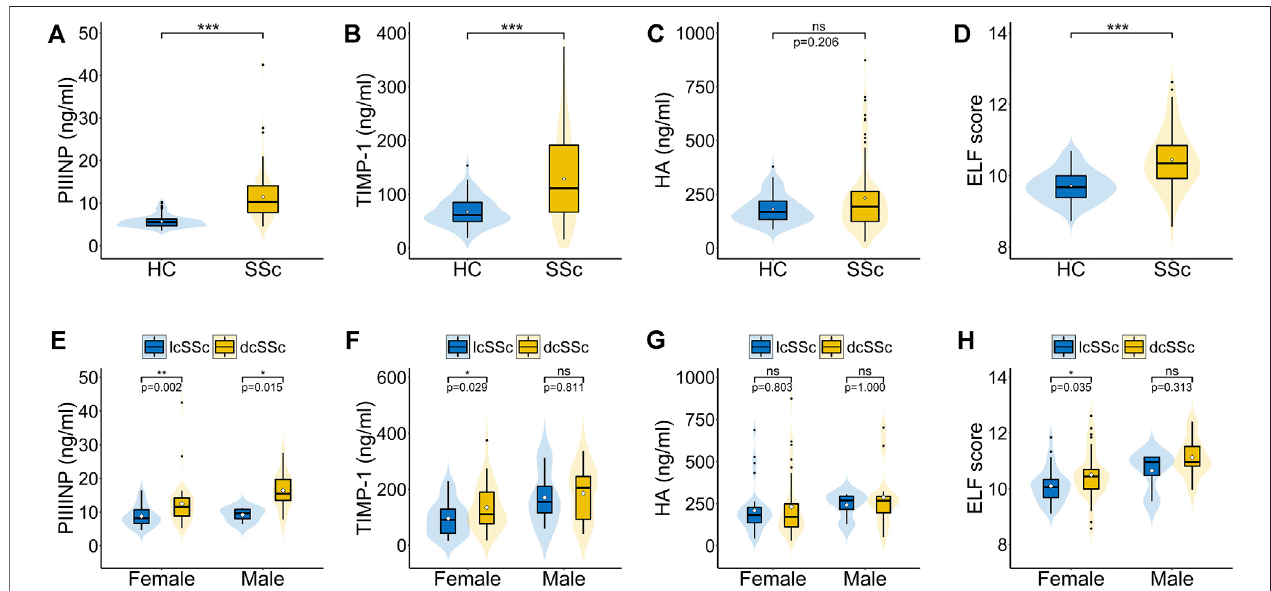
FIGURE 1 | Serum PIIINP, TIMP-1, HA levels and ELF score in patients with SSc. (A – D) Serum PIIINP, TIMP-1, HA levels and ELF score in patients with SSc compared with healthy controls. (E – H) Serum PIIINP, TIMP-1, HA levels and ELF score in patients with diffuse cutaneous SSc compared with limited cutaneous SSc in malesandfemales. Aviolinplotincludes afatlineshowingthemedianofthedata,aboxrepresentingtheinterquartilerange, upper andlowerbarsindicatingthe5thand 95th centiles, and ashadow presentingthekernel probabilitydensity ofthedata at differentvalues. The blackdots stand foroutliersand thewhitediamonds stand for mean values. HC, healthy controls; dcSSc, diffuse cutaneous SSc; lcSSc, limited cutaneous SSc; ns, not signi fi cant. *** p < .001, ** p < .01, * p < .05.